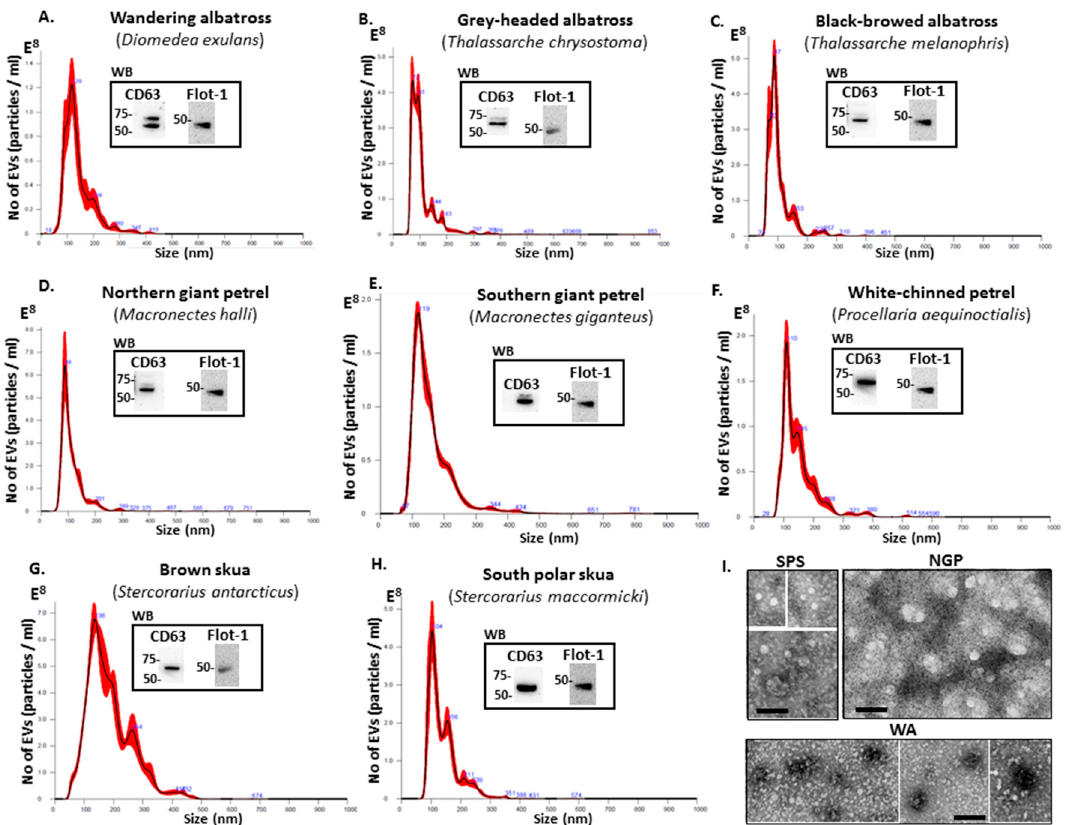
Figure 1. Extracellular vesicle (EV) profiles of seabird plasma. ( A – H ) Nanosight particle tracking analysis (NTA) and Western blotting analysis (WB) of EVs isolated from the 8 bird plasma shows some variation in EV size distribution profiles as represented by the histograms and positive immunoblotting with two phylogenetically conserved EV-specific protein markers, CD63 and Flot-1. ( A ) Wandering albatross ( Diomedea exulans ); ( B ) Grey-headed albatross ( Thalassarche chrysostoma ); ( C ) Black-browed albatross ( Thalassarche melanophris ); ( D ) Northern giant petrel ( Macronectes halli ); ( E ) Southern giant petrel ( Macronectes giganteus ). ( F ) White-chinned petrel ( Procellaria aequinoctialis ); ( G ) Brown skua ( Stercorarius antarcticus ); ( H ) South polar skua ( Stercorarius maccormicki ); ( I ) Transmission electron microscopy (TEM) composite images represent examples of EVs isolated from wandering albatross (WA), northern giant petrel (NGP) and south polar skua (SPS); scale bars indicate 100 nm for all images.